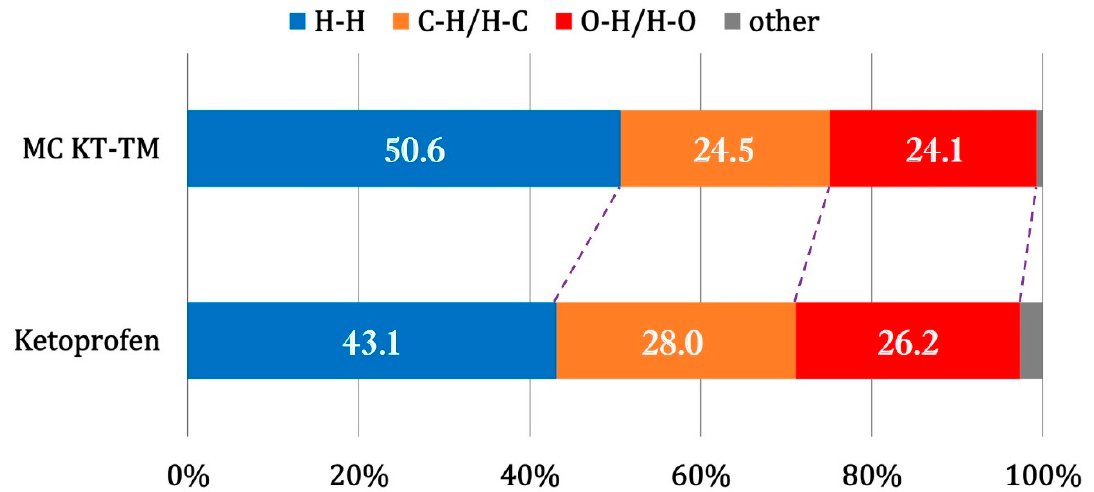
Figure 12. The relative contribution of different interactions to the Hirshfeld